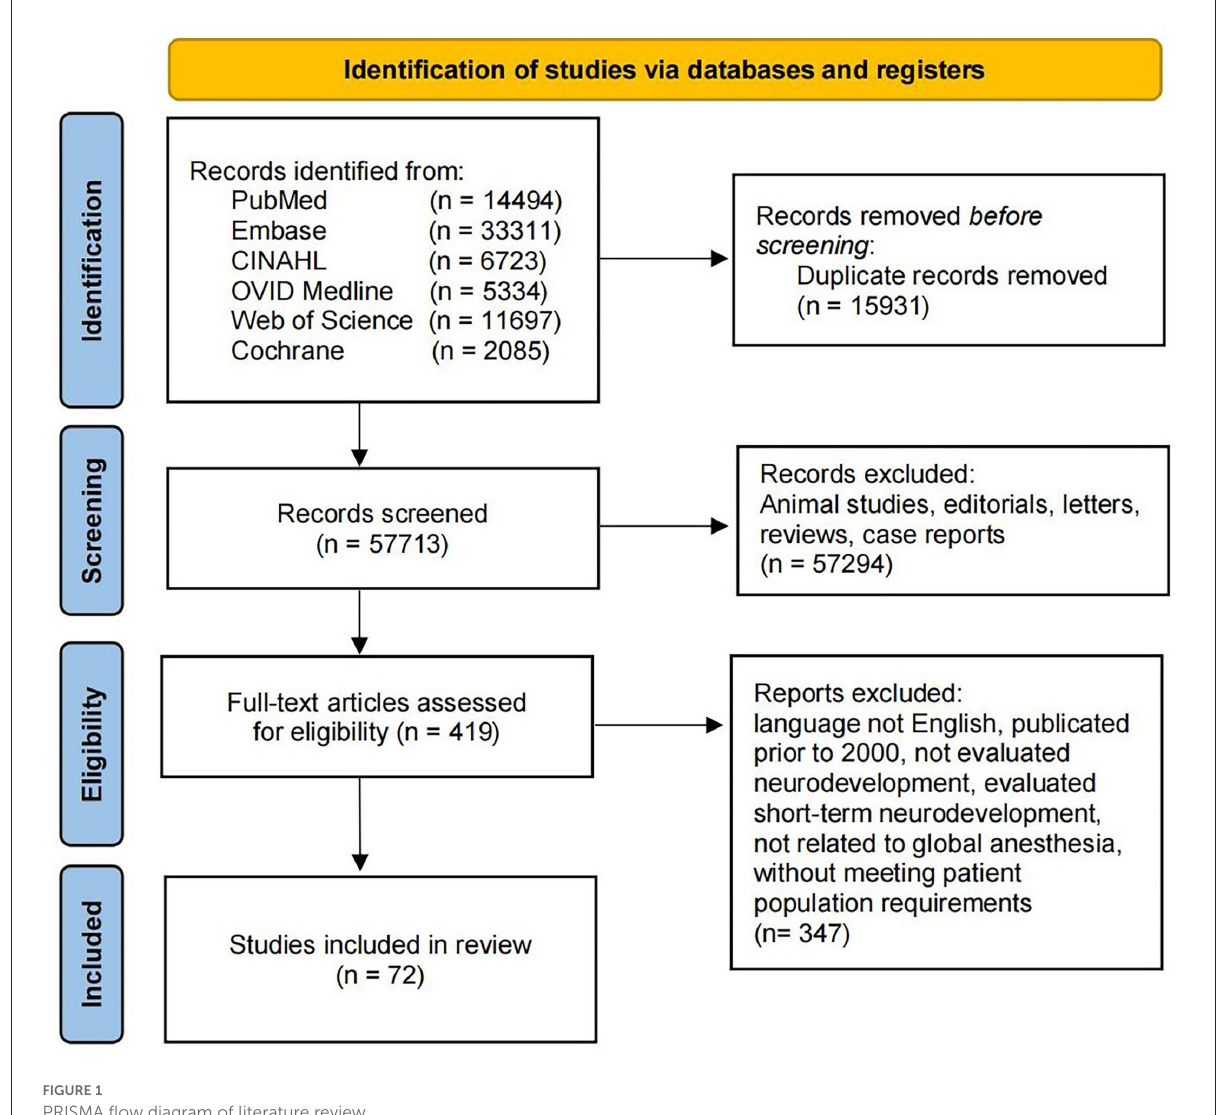
FIGURE1 PRISMA flow diagram of literature